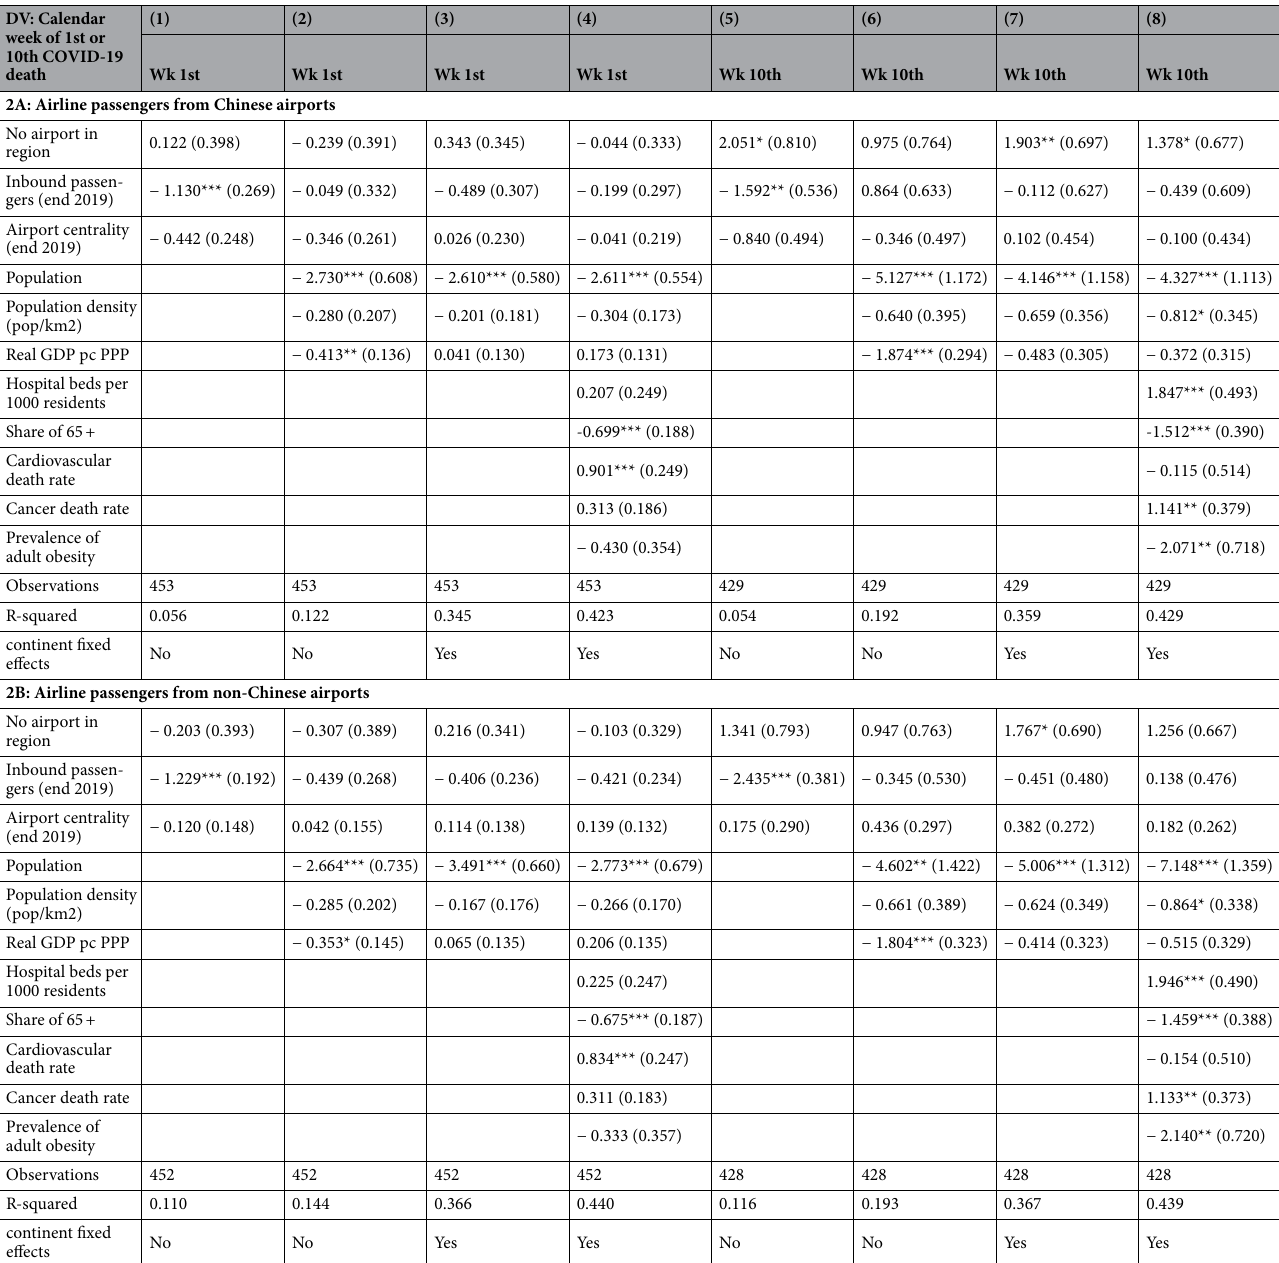
Table 2. The impact of late 2019 air passenger traffic on the precocity of COVID-19 outbreaks (calendar week of occurrence of 1st and 10th death) [2A: traffic from Chinese airports; 2B: traffic from other airports]. Source : Sub-National COVID-19 Incidence and Determinants Dataset. OLS regressions without and with continent fixed effects. Standard errors in parentheses. * p < 0.05, ** p < 0.01, *** p <